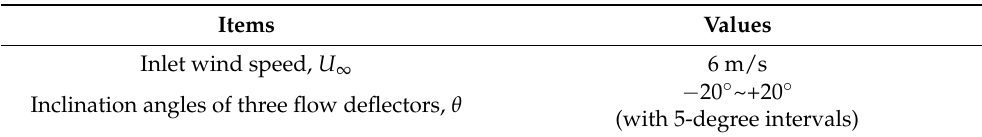
Table 1. Conditions of inlet wind speed and inclination angles of wind-collecting casing for output performance test experiment and numerical flow simulation.